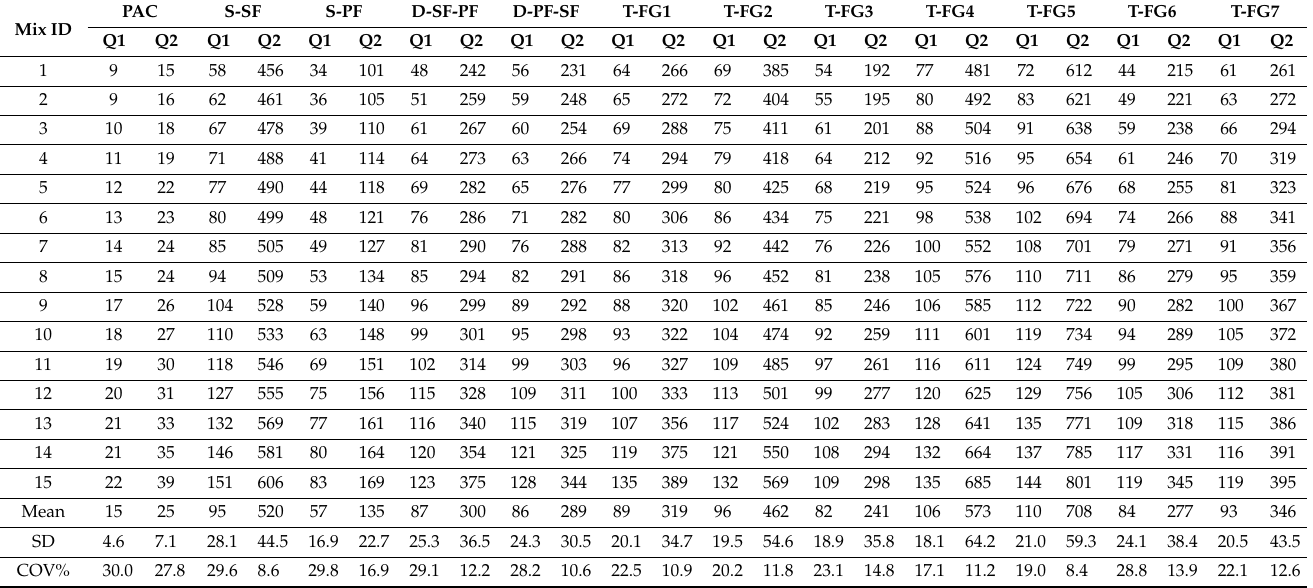
Table 3. Test results of modified falling mass